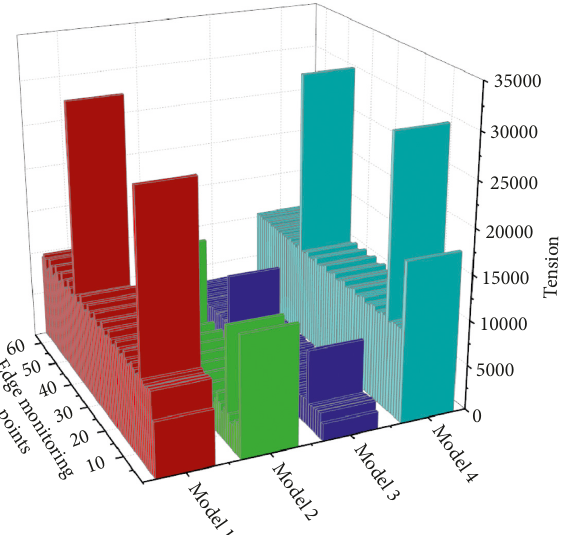
Figure 18: Equivalent stress histogram of U-shaped steel under blasting disturbance. Model 1 to Model 4 refer to the equivalent stresses of U-shaped steels with explosion amounts of 32 kg, 40kg, 48kg, and 60kg, respectively.